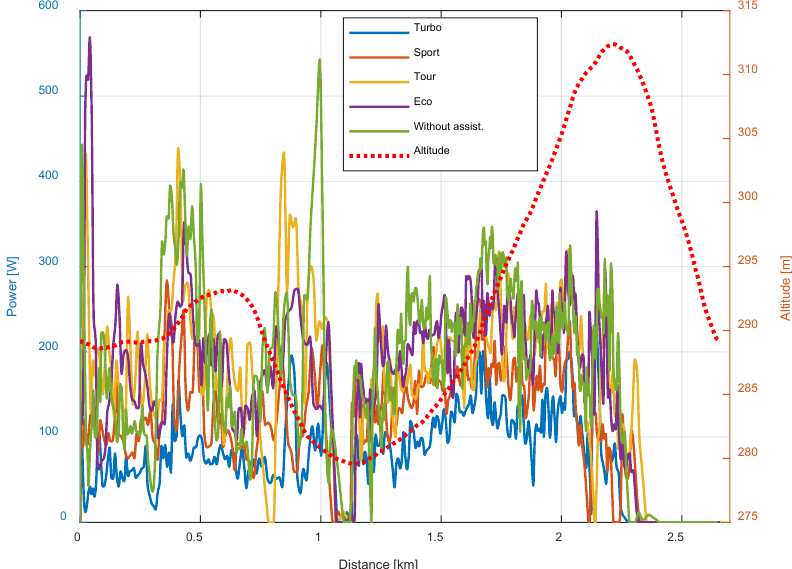
Figure 8. The power generated by the rider in a variety of assist modes.